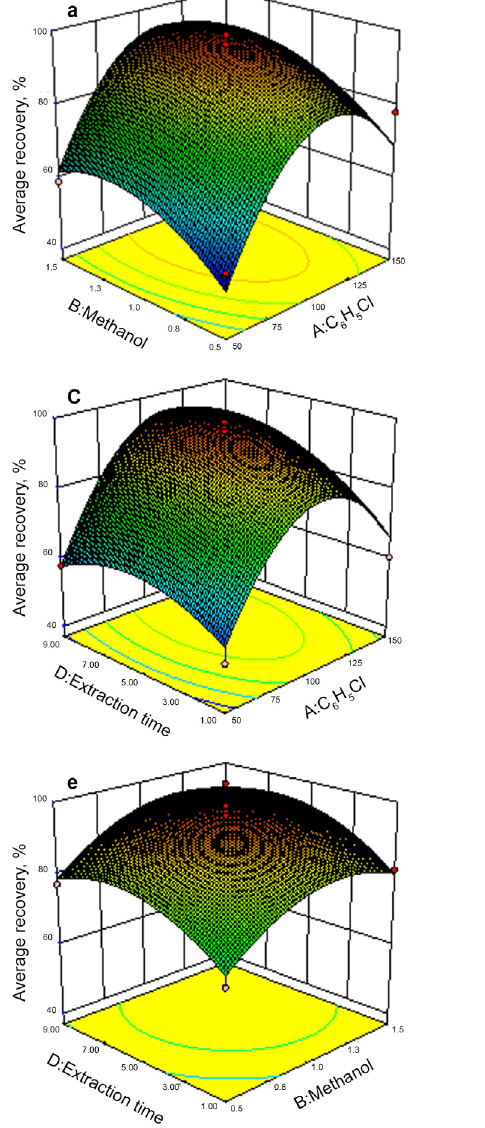
Fig. 4. Effect of various parameters on the average recovery of OCPs and PCBs in the DLLME procedure a) Response surface plots showing the effect of C time and C H Cl volume; (d) pH and methanol volume; e) extraction time and methanol volume; f) extraction time 6 5 and